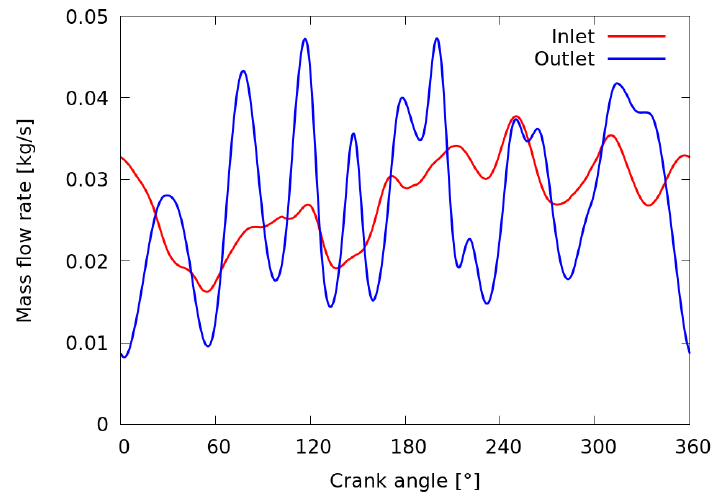
Figure 7. Flow rate variation over a revolution of the